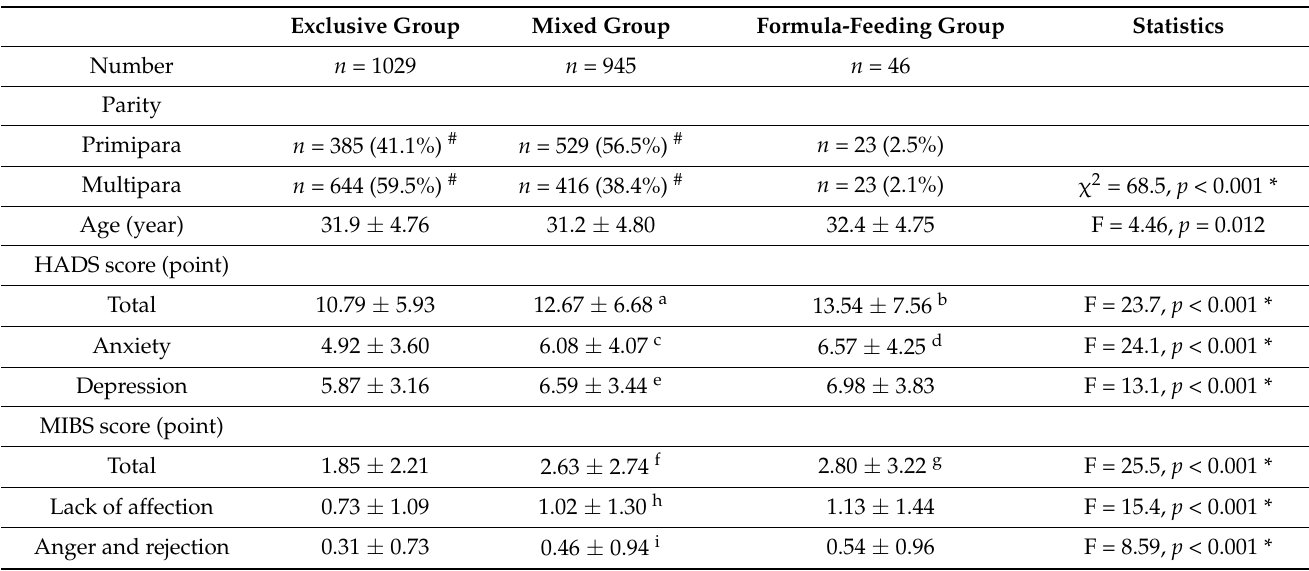
Table 1. Comparisons of characteristics between the exclusive breastfeeding group and the non-exclusive breastfeed- ing group. Exclusive Group Mixed Group Formula-Feeding Group